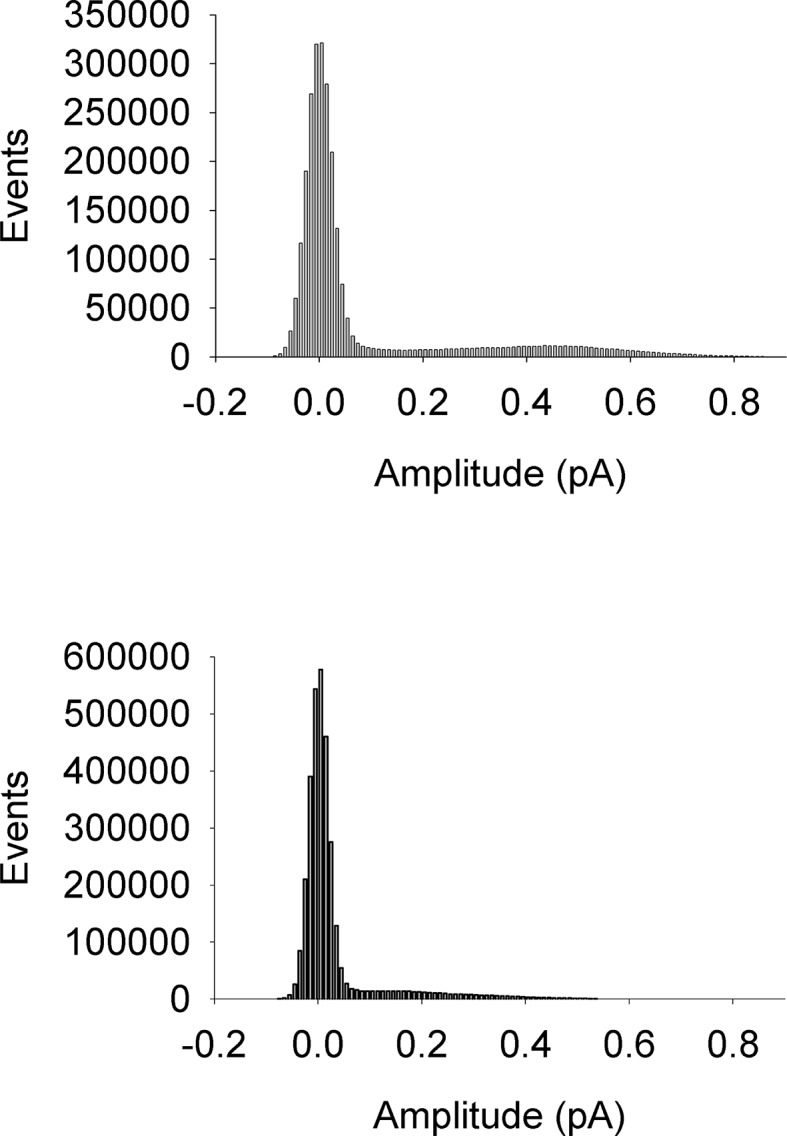
All-points amplitude histograms.All-points amplitude histograms of single channel records during a 60 mV step, filtered at 200 Hz for EQ (upper) and EQQ (lower) including sweeps with no channel activity. These are the same single channel current records as shown in Figure 2B.